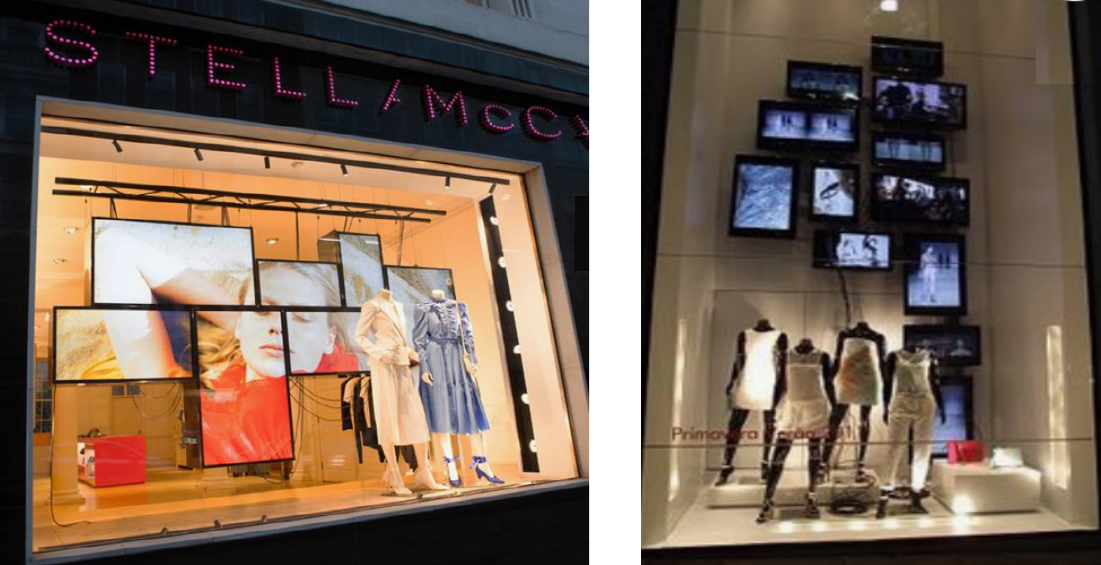
Figure 7. Shadowbox display window style.